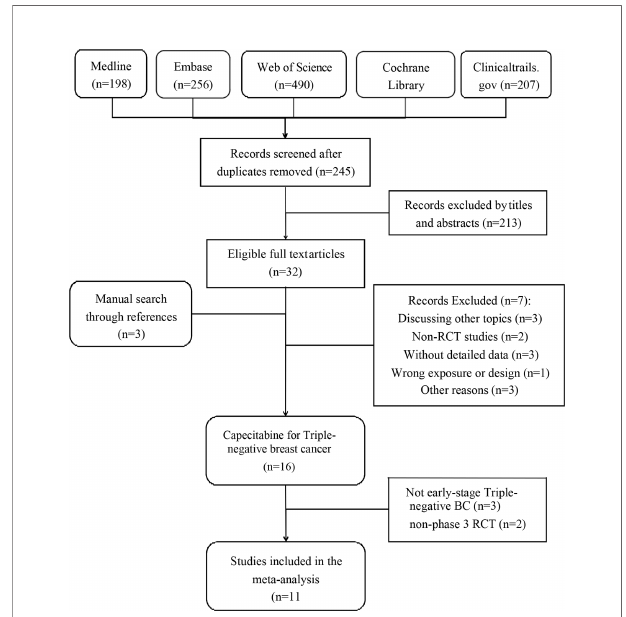
FIGURE 1 | Flowchart of selection of included studies.